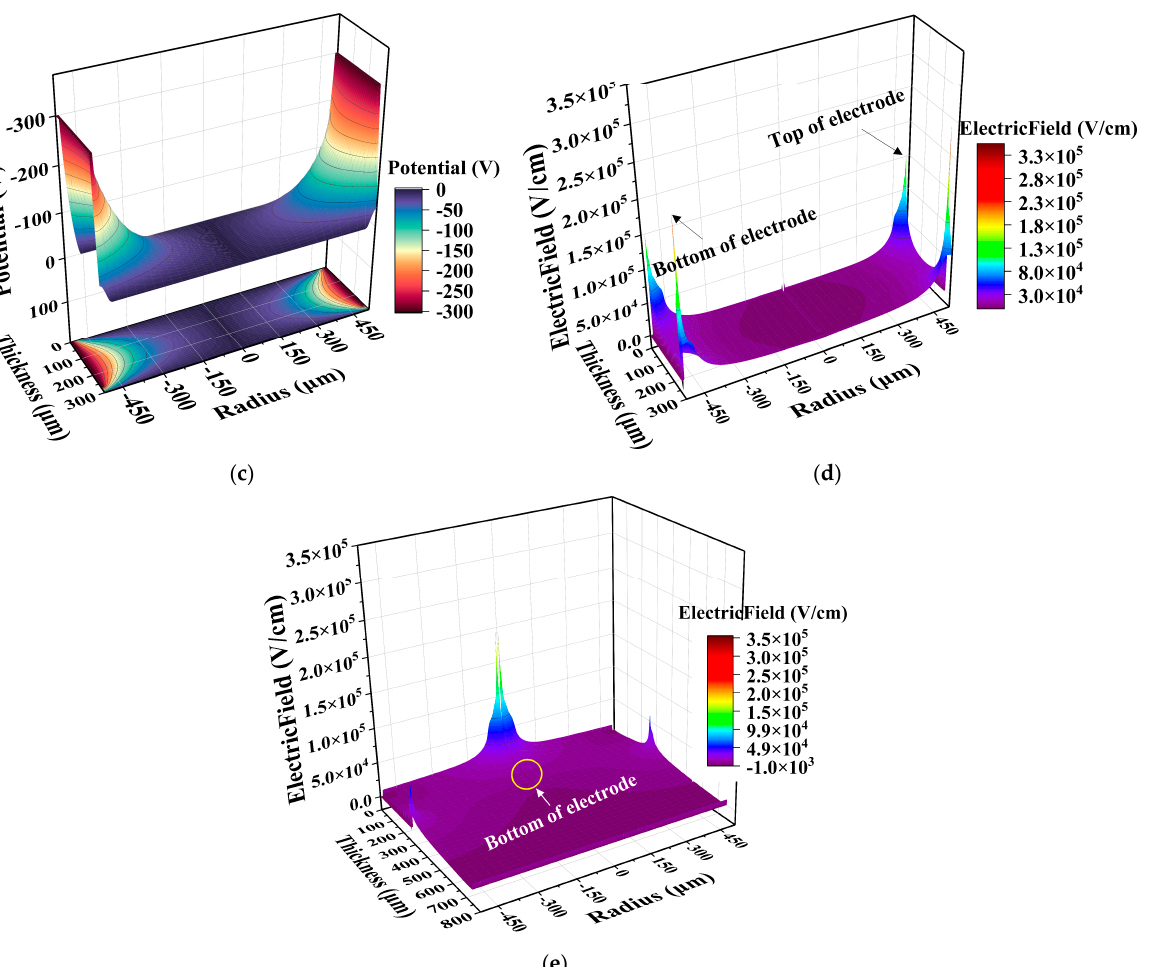
Figure 2. The three-dimensional surface diagram: ( a ) NPP-type potential distribution; ( b ) NPP-type electric field distribution; ( c ) PNN-type potential distribution; ( d ) PNN-type electric field distribution; ( e ) Electric field distribution of wafer thickness 750 μ m.